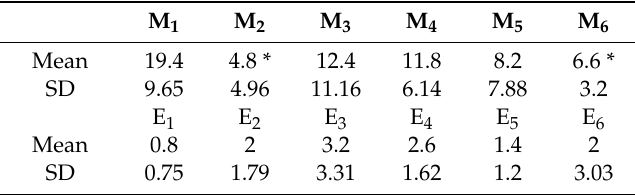
Table 1. Mean ± standard deviation (SD) for minutes spent on the openings and errors per round against each rival.